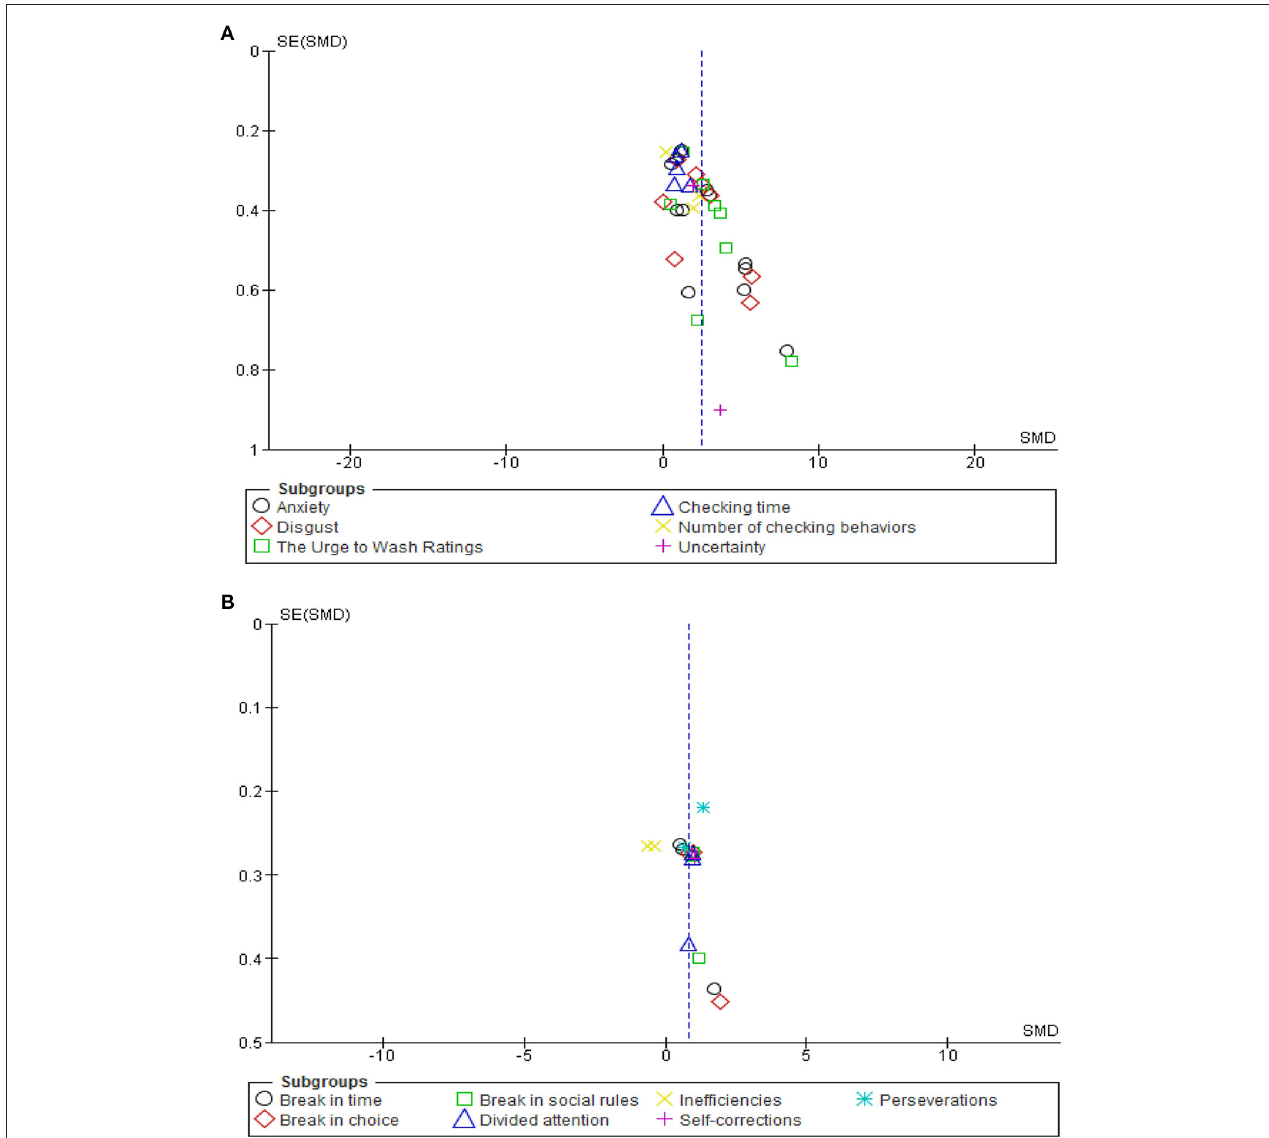
FIGURE 4 | Funnel plot analysis for emotional response (A) to VR environment and VR scoring (B) in patients with